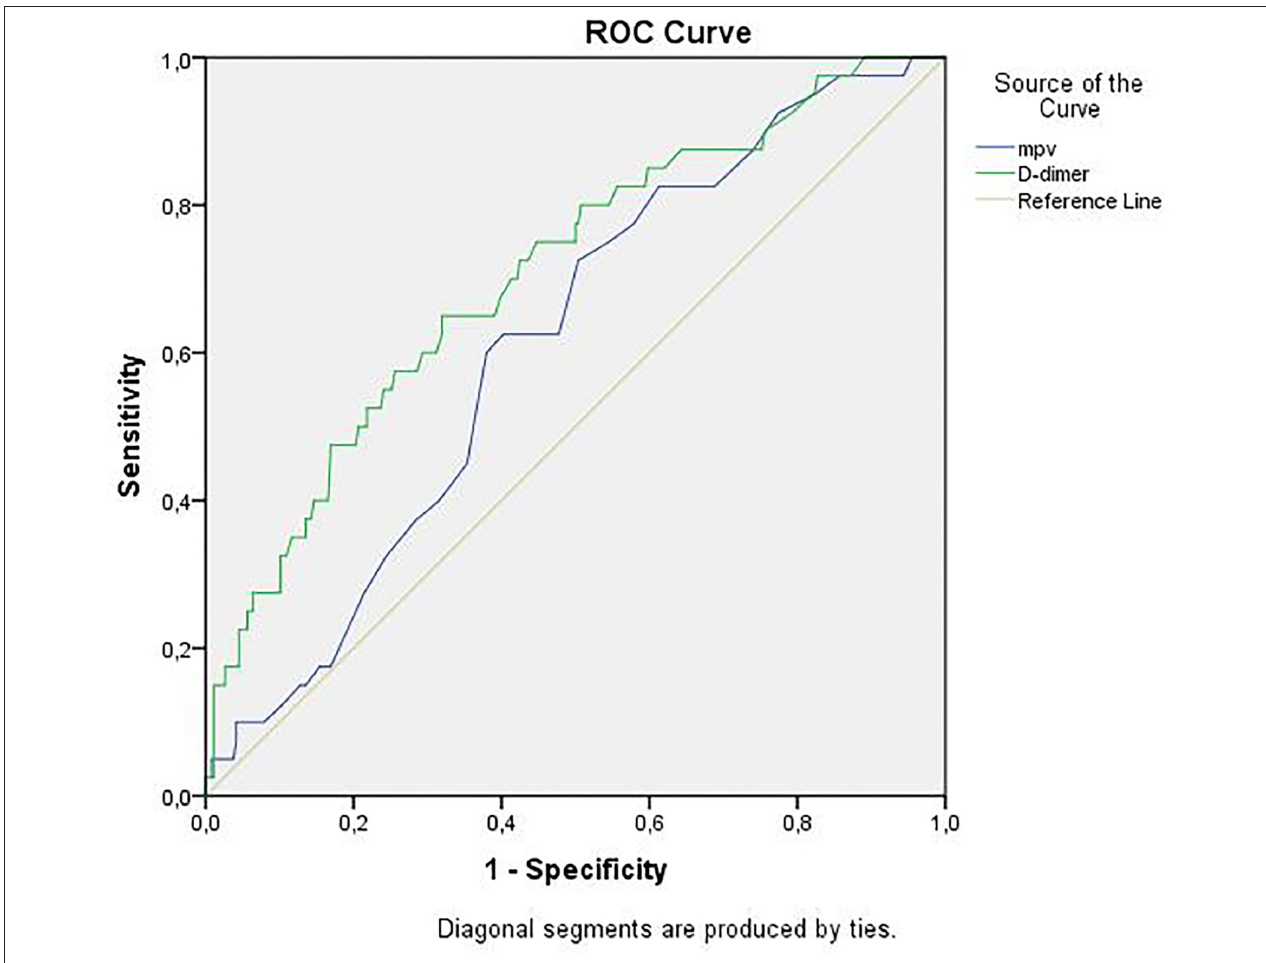
FIGURE 2 | ROC curves of D-dimer and mean platelet volume for intensive care unit transfer state. ROC, receiver operating